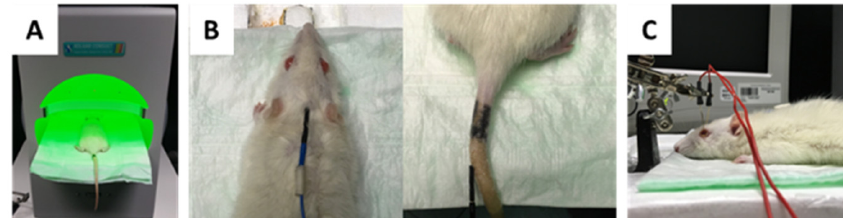
Figure A1. Episcleral vein occlusion on a rat eye. The EVO operation has several intermediate steps: ( A ) Incision of the conjunctiva, exposure of the episcleral veins and closure of the truncti by thermo- occlusion. ( B ) Dissection of the empty vessel to prevent bypass formation. ( C ) Closure of the incision by surgical knots.